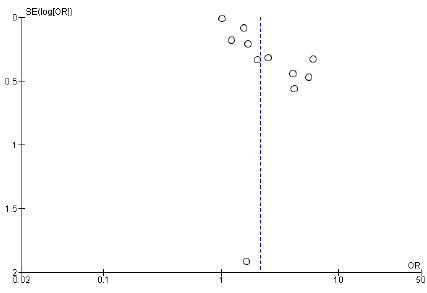
Figure 8. Funnel plot of studies on association between QDC and depression. Note: dot represents individual studies; blue dotted line represents the overall effect.